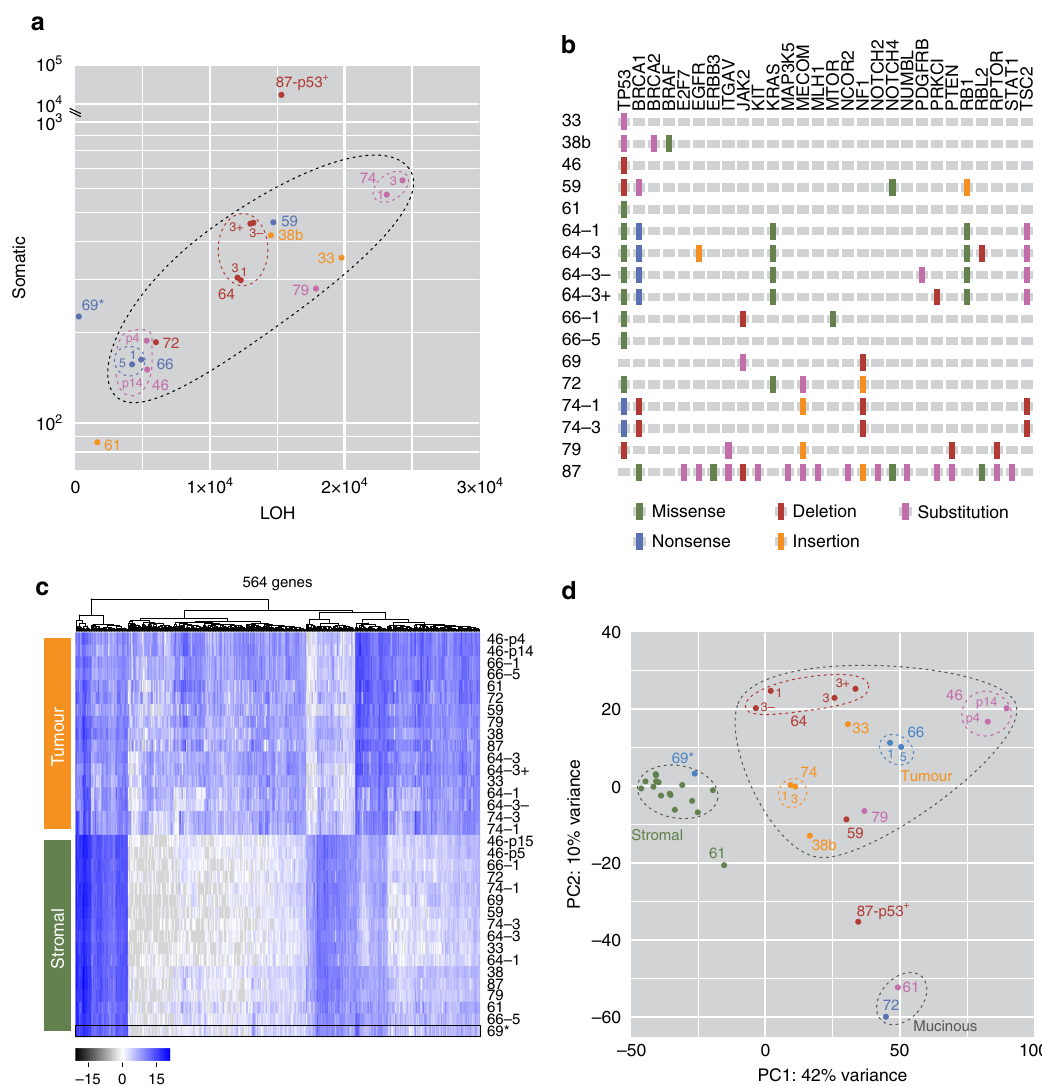
Fig. 3 Exome and gene expression analysis. a Whole-exome sequencing showing somatic and loss of heterozygosity variants identi fi ed by referencing tumour cells to their matched stromal counterparts. b Summary of mutations in genes associated with HGSOC. c Hierarchical clustering and d principal component analysis of global gene expression pro fi les, distinguishing stromal and tumour clades, and showing the close relationship of tumour samples from the same patient. 69* is a stromal culture. Symbol colours in a and d serve to distinguish different OCM tumour samples. Source data for panels a and d are provided as a Source Data fi